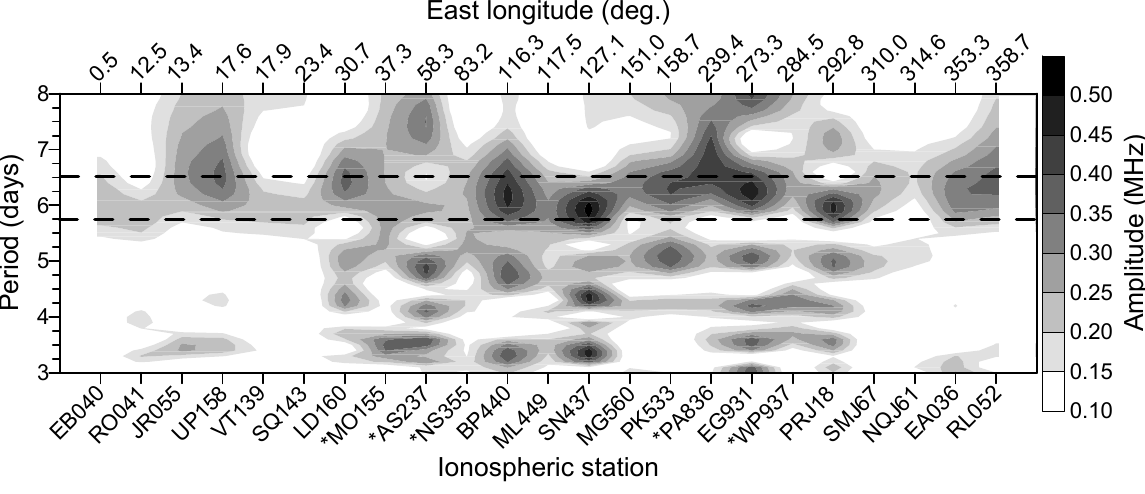
Fig. 7. Period-longitude cross sections of the amplitude spectra of the fo F2, note that the longitude x -axis is not equally spaced. Amplitudes above 0.2MHz are statistically significant above the 0.95 confidence level. See text for